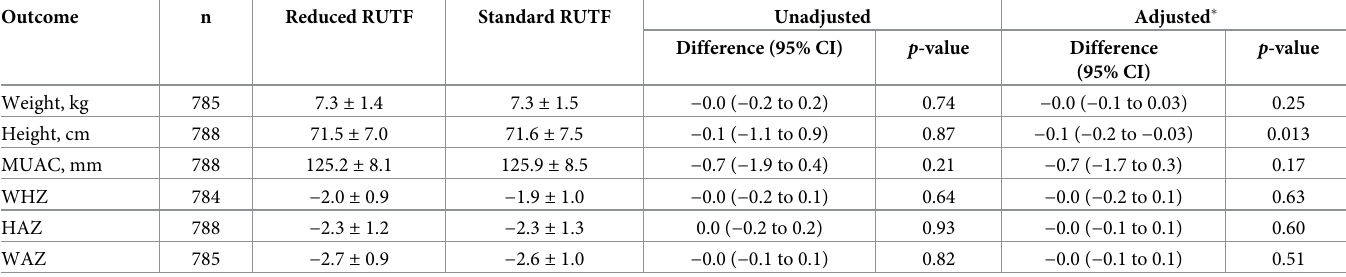
Table 4. Anthropometry at discharge of children with SAM randomised to reduced or standard RUTF dose with difference (95% CI) in unadjusted and adjusted ITT analysis. Outcome n Reduced